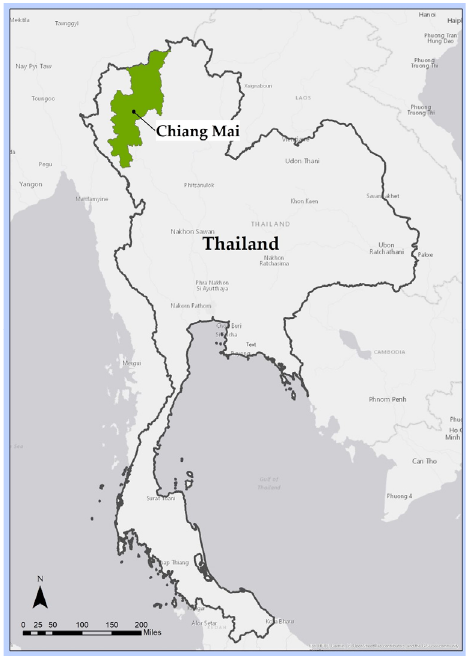
Figure 1. A geographic of the Chiang Mai province of northern Thailand.